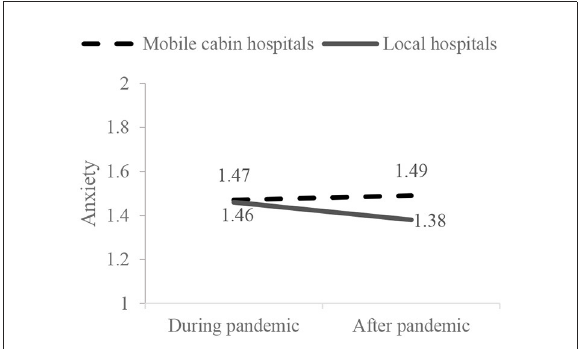
FIGURE1 Interactive effects on the medical staff’s anxiety.